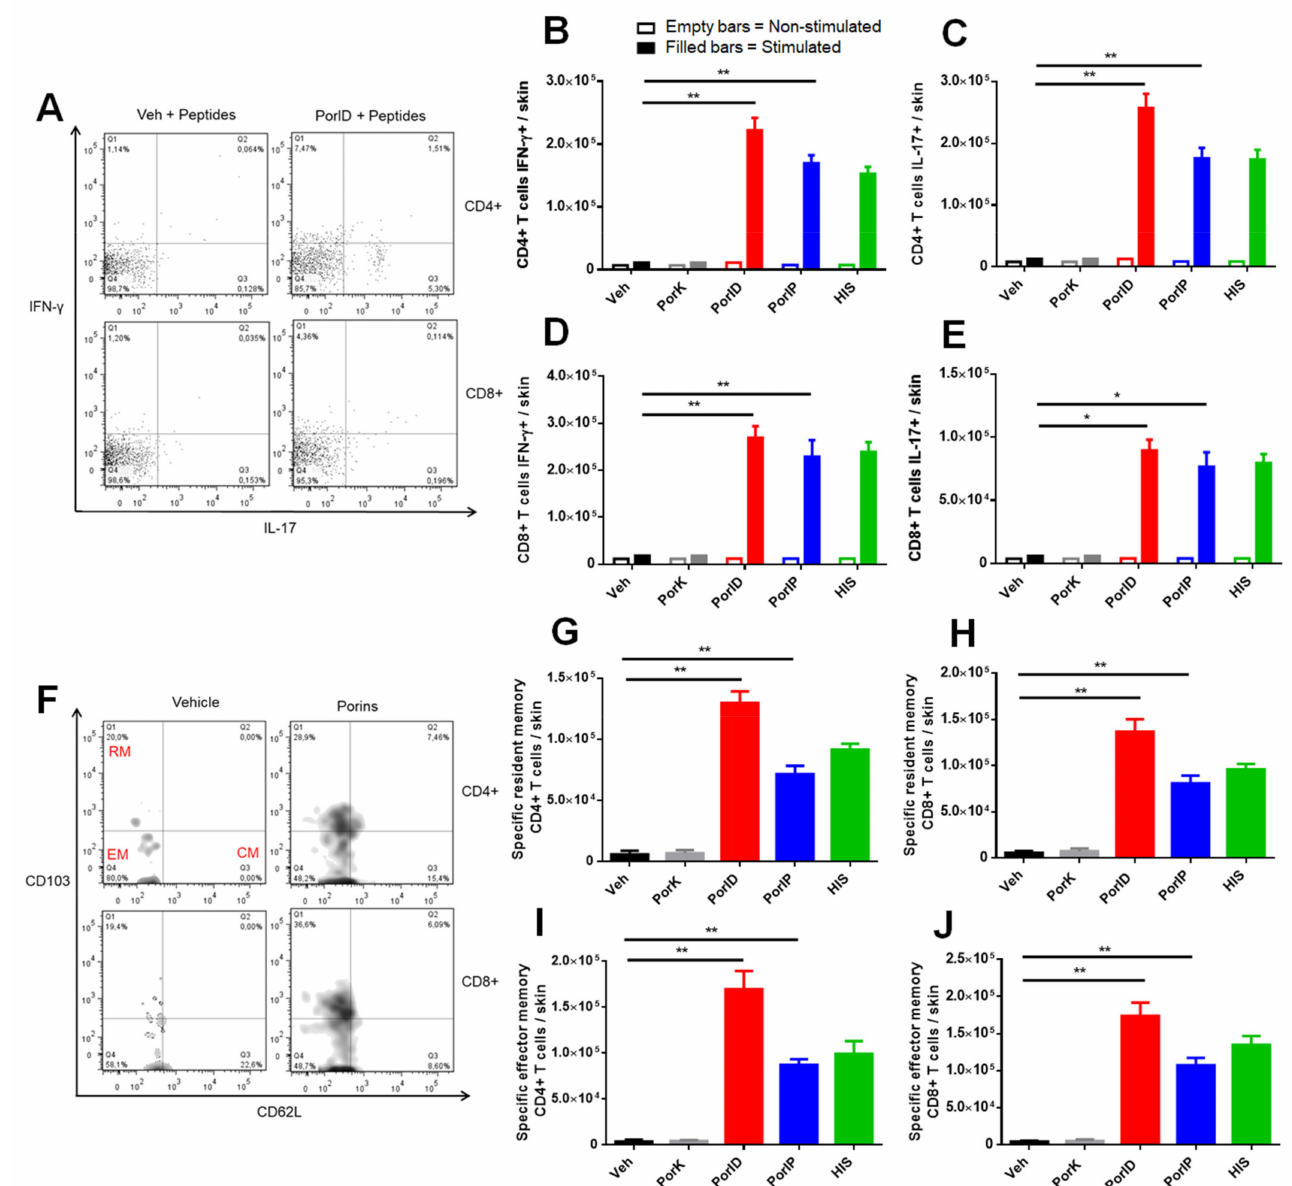
Figure 2. Vaccination with S . Typhi porins induces functional resident and effector memory CD4+ and CD8+ T cell responses. C57BL/6J mice were injected intradermally in the ear with vehicle (Veh), proteinase K-digested porins (PorK), porins (PorID), or intraperitoneally with porins (PorIP) or heat-inactivated S . Typhi (HIS) at day 0. All groups were boosted at day 14 with porins injected intradermally in the ear. At day 28, expression of IFN- γ and IL-17 was evaluated in skin T cells following stimulation with S . Typhi porins peptides. Representative plot ( A ) used to analyze the total number of IFN- γ + ( B ) and IL-17+ ( C ) CD4+ T cells. Total number of IFN- γ + ( D ) and IL-17+ ( E ) CD8+ T cells. At day 28, memory phenotype T cells (CD44+) were evaluated in the skin. Representative plot ( F ) used for the detection of both effector memory (CD62L − , CD103 − ) ( G , H ) and resident memory (CD62L − ,CD103+) ( I , J ) CD4+ and CD8+ T cell populations, respectively (CM, central memory, EM, effector memory, RM, resident memory) ( n = 7; 2 independent experiments; significant difference for a Kruskal–Wallis test ** p < 0.05 * p < 0.1 with Dunn ´ s multiple